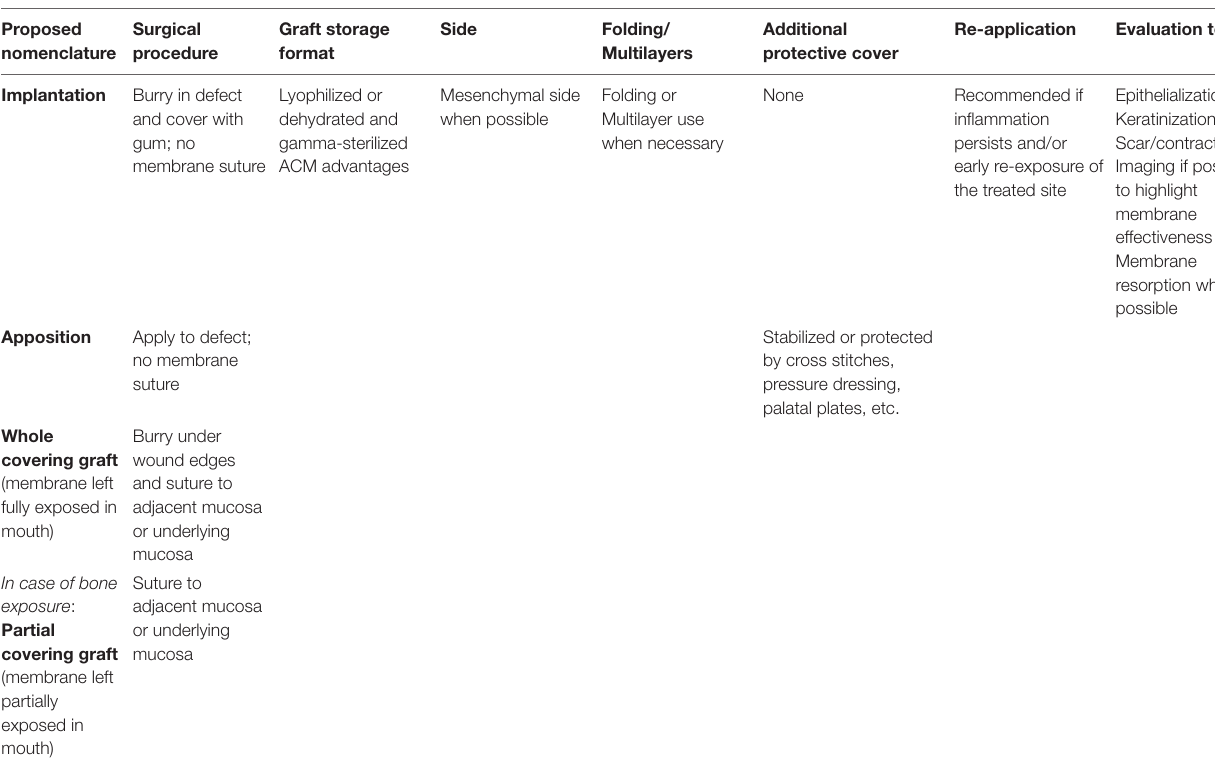
TABLE 3 | Summary of future recommendations for hAM/ACM application in oral